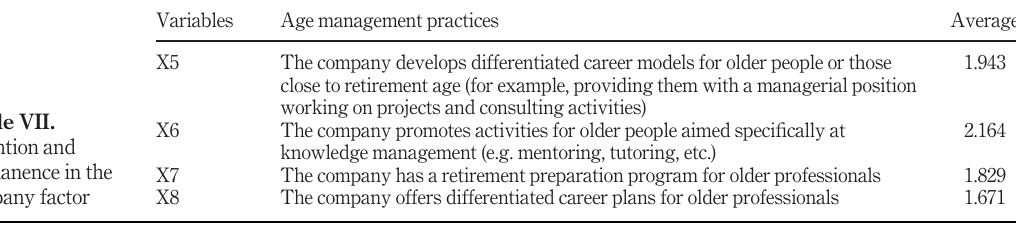
Table VIII. Adaptation to the needs of the professional factor